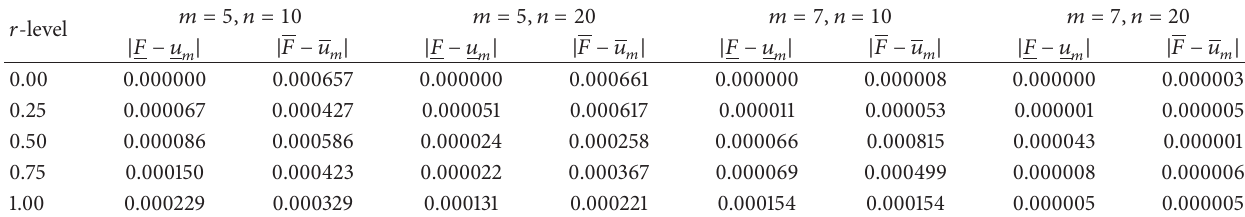
Table 1: Numerical results on the level sets for Example 1 in (𝑠 0 , 𝑡 0 ) = (0.5,0.5) .